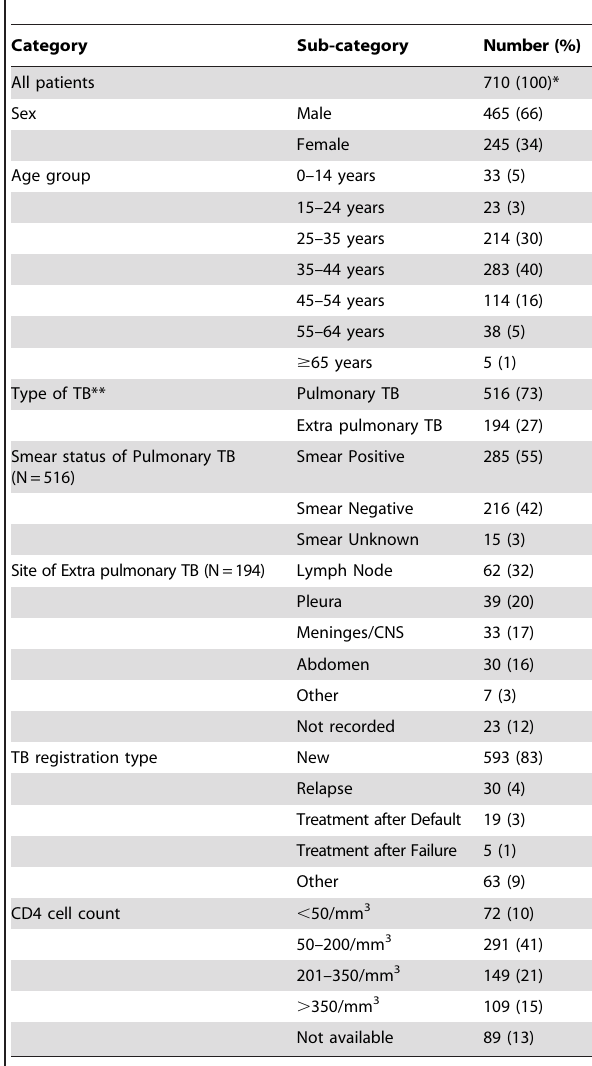
Table 1. Characteristics of HIV-infected TB patients registered in Karnataka state, India, in June